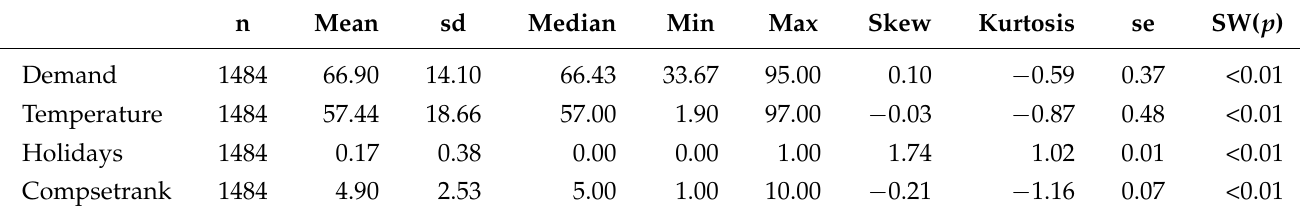
Figure 1. Daily totals for demand and temperature. Table 1. Descriptive statistics for dataset (December 2015–December